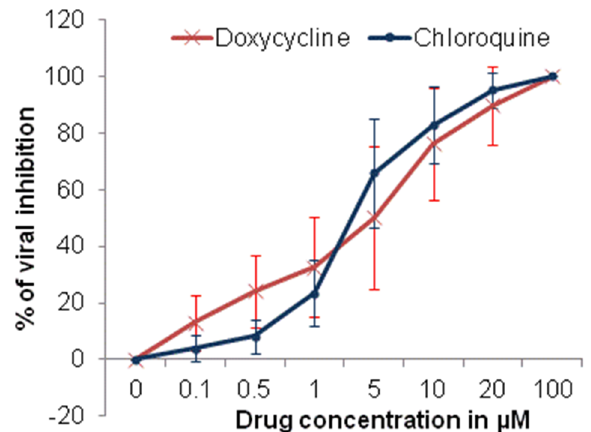
Figure 1. Comparative antiviral efficacy of doxycycline and chloroquine against SARS-CoV-2 infection in vitro (error bar represents standard deviation, 10 experiments).